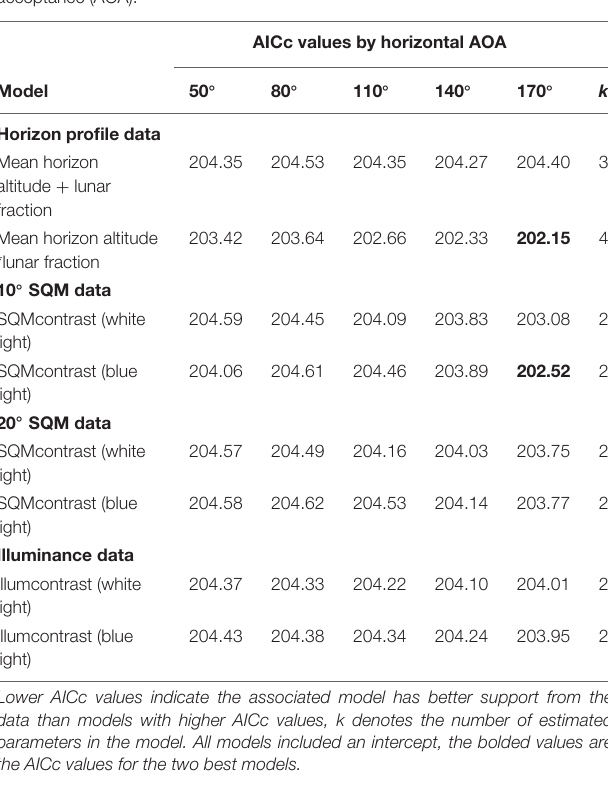
TABLE 5 | Model selection results for hatchling misorientation models that do not involve an angle of